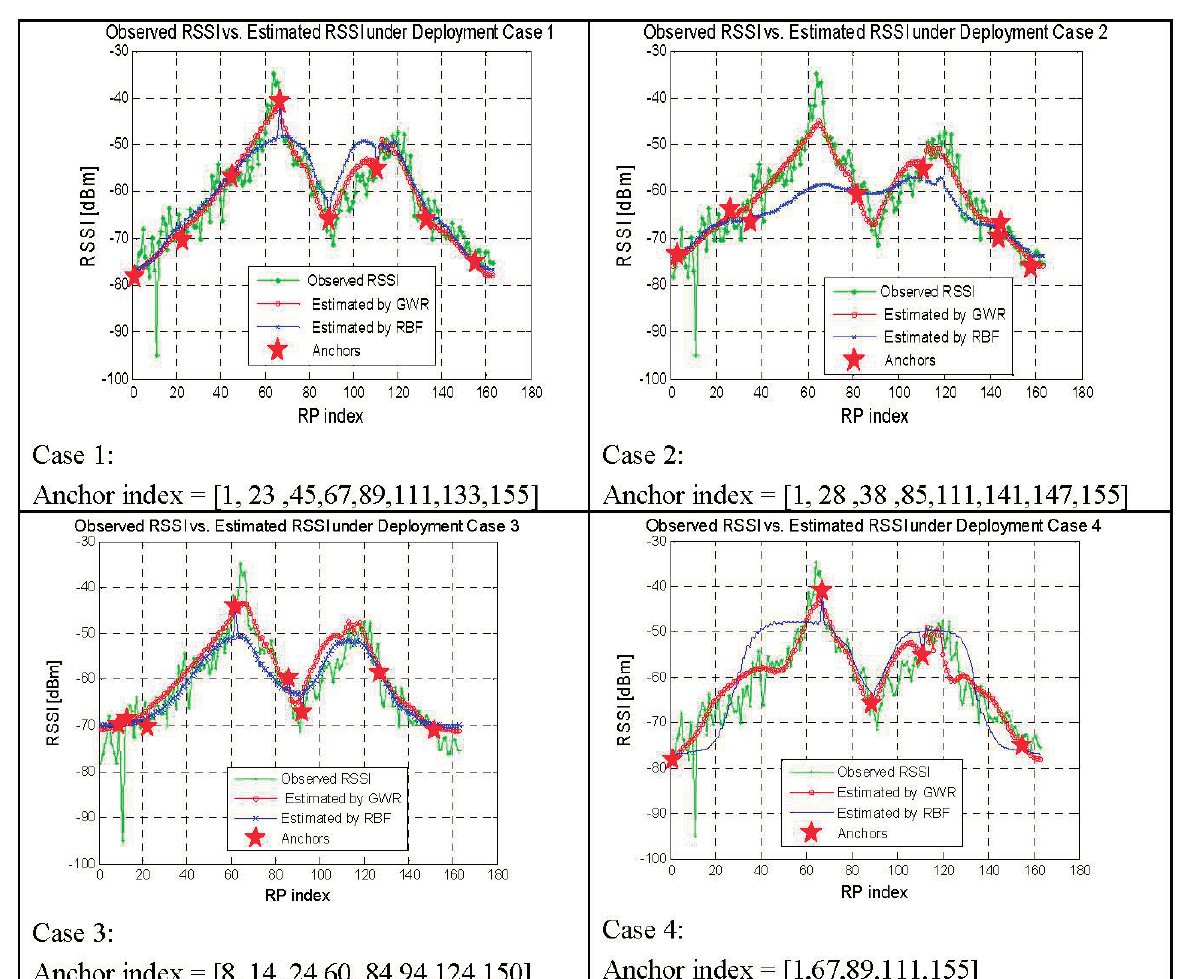
Figure 14. Impact of the anchors in four